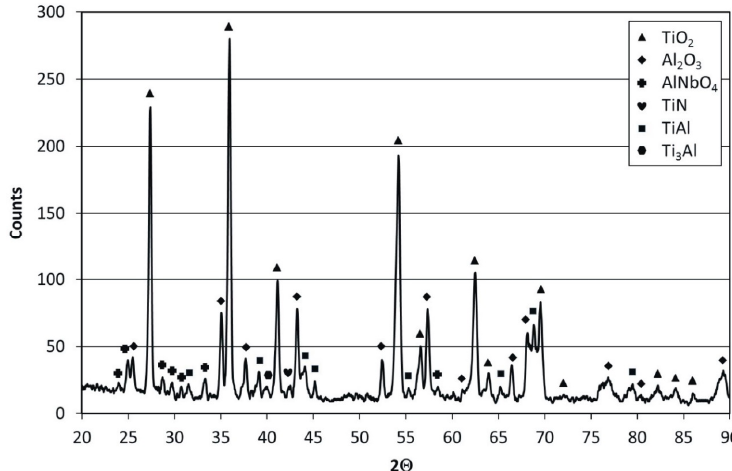
Figure 11. X-ray diffractogram of the oxide scale formed on Ti–45Al–8Nb–0.5(B, C) alloy after 25 oxidation cycles at 950 °C.